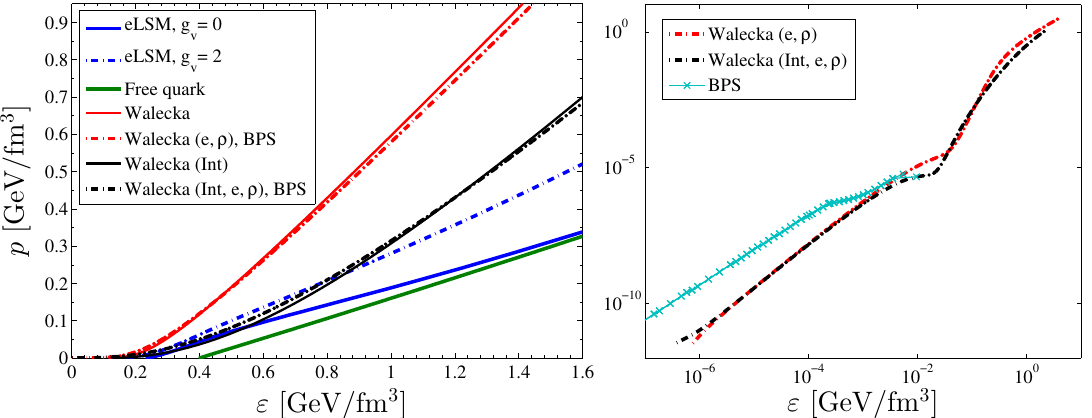
Figure 1. Left panel: The T = 0 equation of state (EoS) of the extended linear sigma model (eLSM) (blue solid line for g v = 0 and blue dashed-dotted line for g v = 2) compared to those of the free constituent quark matter with mass values given in the text (green solid line) and of the Walecka model with (black lines) and without (red lines) the scalar self-interaction. For the latter model the dashed–dotted line type indicates that β -equilibrium and charge neutrality are imposed, the ρ meson is included, and that at low energy densities the EoS is replaced by the BPS EoS. Right panel: Matching the EoS of the Walecka model to the BPS EoS (see the text for details). Notice that the consequence of imposing the mentioned compact star constraints (inclusion of electrons and ρ ) in the Walecka model is that p ( ε ) > 0 even at low energy